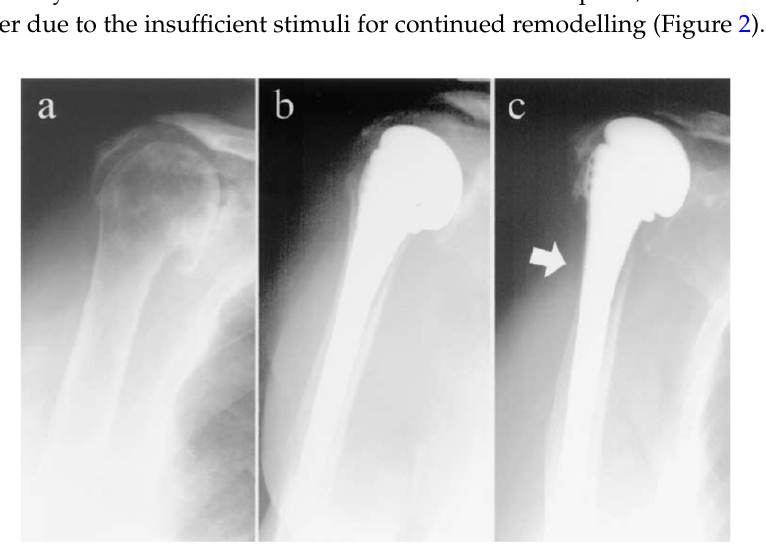
Figure 2. Stress-shielding example in shoulder replacement surgery; ( a ) preoperative image; ( b ) image immediately after the surgery; ( c ) image after 7 years from the surgery; arrow indicates the region of bone resorption. Reproduced with permission from [36], Elsevier, 2003.